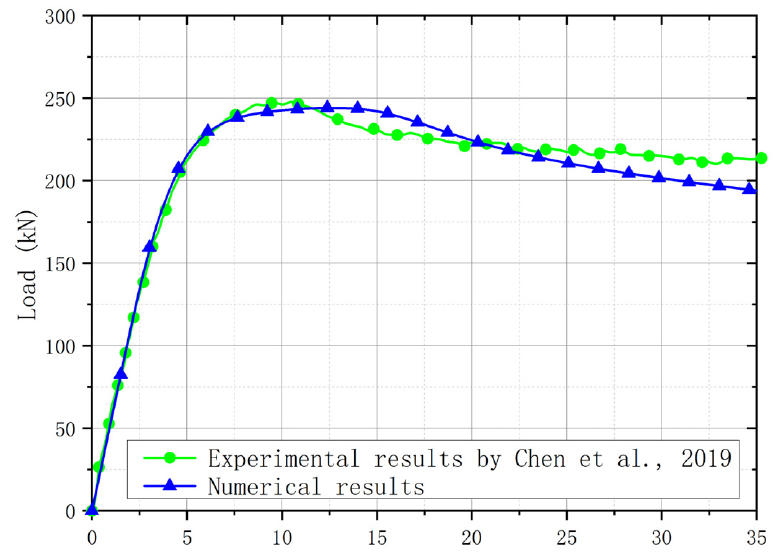
Figure 7. Comparison between experimental [54] and numerical results for the plate girder under high-moment high-shear loading.